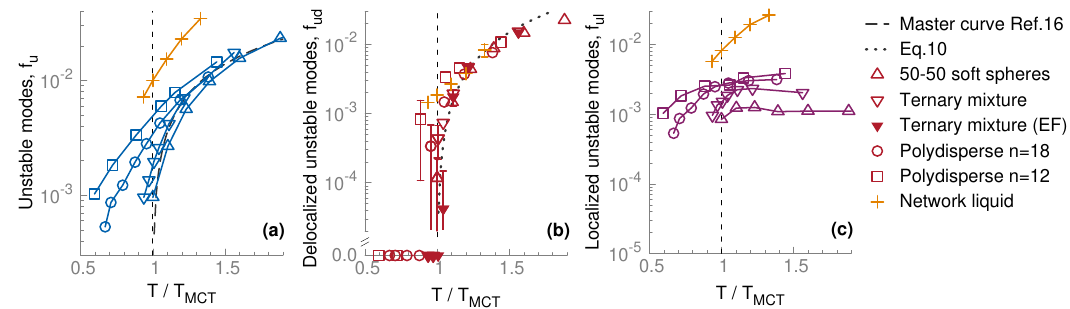
Figure 1: Fractions of unstable modes in stationary and quasi-stationary points for all studied models. Rescaled temperature dependence of (a) total fraction f modes from W -minimizations. The dashed line is the master curve found in Ref. [ 16 ] . (b) Fraction f of delocalized unstable modes. Open and filled symbols correspond ud to W -minimizations an EF optimizations, respectively. The dotted line is Eq. (10) = 0.042. Error bars are shown when the relative error exceeds 20%. (c) with f 0 Fraction of localized unstable modes from W